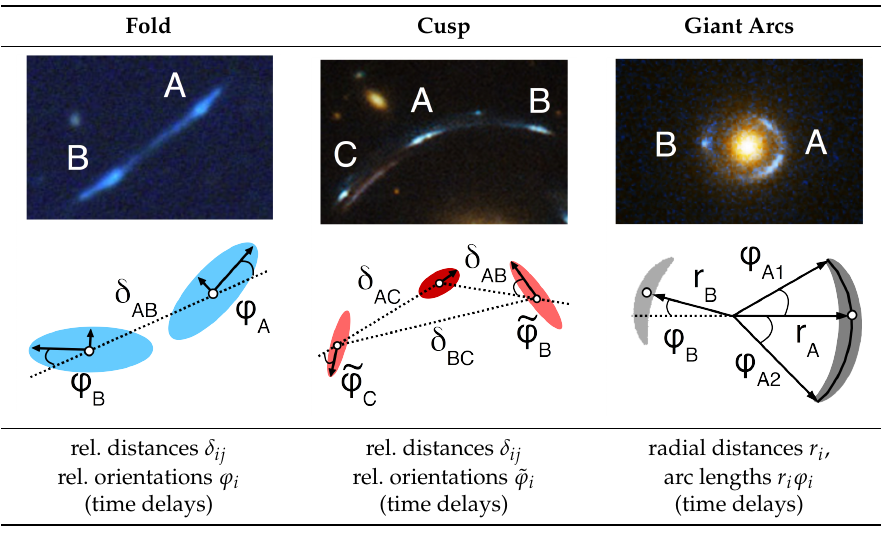
Table 2. Special multiple-image configurations of a common source. The figure shows an observed example, the schematic underneath the observables for unresolved images. Point-like and resolved images can also form these configurations. The bottom rows list the quantitative observables for each case. For arcs, we assume the centre of brightness of the lens is known. Image credits: